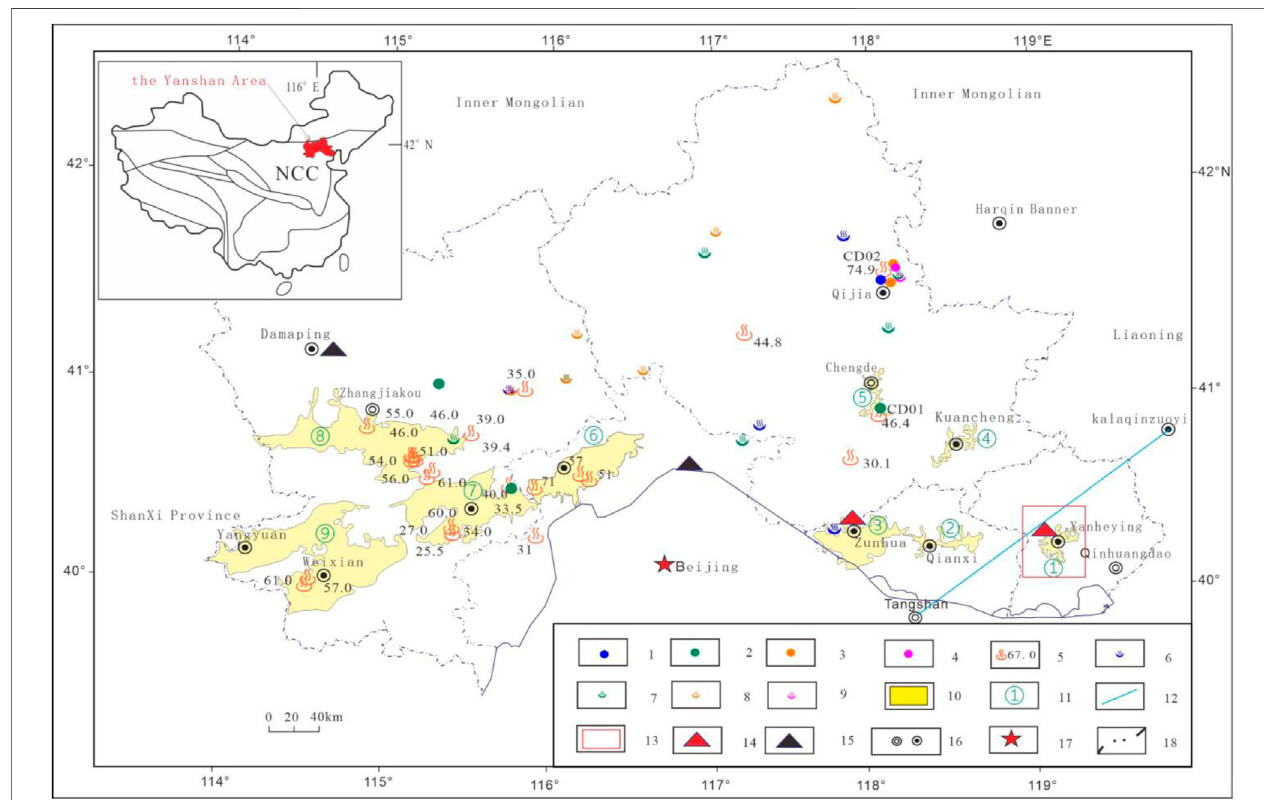
FIGURE 1 | Terrestrial heat fl ow observations and surface geothermal manifestations in the Yanshan area.